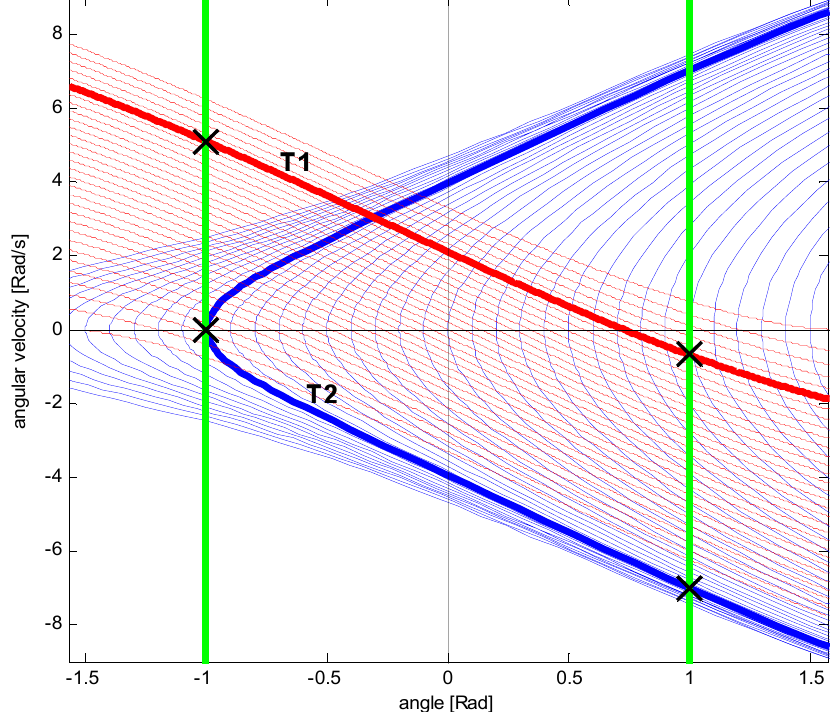
Figure 6. Theoretical balanceable region for an unrealistic input constraint of (cid:3398)500 (cid:3409) (cid:1873) (cid:3409) (cid:3397)1000 (cid:4670)(cid:1840) (cid:1865)(cid:4671) to show how to deal with a case where no stable subspace exists. Red curves are stable subspaces for all the inputs for which a stable subspace exists (condition 10). (cid:1845)(cid:1845)(cid:4666)(cid:3398)500(cid:4667) forms the upper border of the balanceable region (the thick red curve, (cid:1846) (cid:2869) ). For (cid:1873) (cid:3404) (cid:3397)1000 , no stable subspace exists, and the extreme trajectory should be used instead. Blue curves are state trajectories of system (4) for (cid:1873) (cid:3404) (cid:3397)1000 , and the extreme trajectory is the thick blue one ( (cid:1846) (cid:2870) ). All trajectories below (cid:1846) (cid:2870) cannot be kept inside (cid:2290) by the system, and those above it are able to be driven to an equilibrium point, and therefore are able to be driven to the origin. Lateral boundaries are imposed by the state constraint (green lines). The balanceable region for this system is the area between the “x”